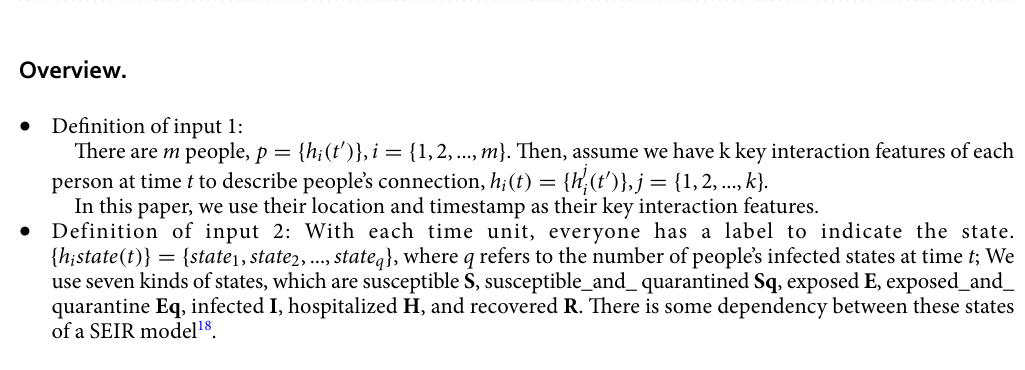
Figure 2. The CLIIP temporal learning framework has two inputs. The first one is continuous spatial data for building an IDG, and the other is a set of labels that provide people’s infected states. Combining interaction data with the states and the relation, we can train this model to learn continuously when new data comes into the framework. The updating IDG is built through comparing the place where two people stop and their overlap time, which defines the relation between two people. An arrow points to the person who stayed longer at a waypoint than the other. According to the path of virus transmission 29 , people’s continuous spatial data are a set of essential interaction features, X i , i = 1, 2, 3... , which we use from mobile location data and we can call interaction